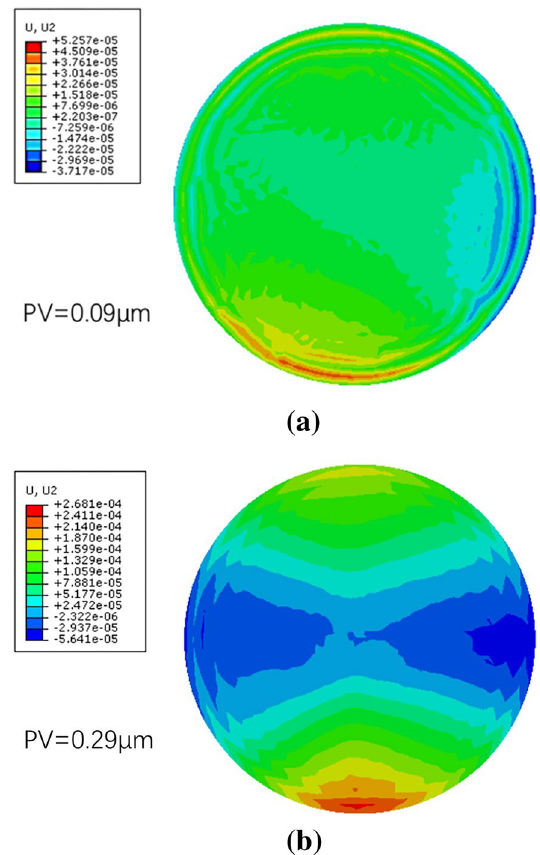
Figure 12 Simulation results of workpiece deformation caused by processing stress: ( a ) Strategy I; ( b ) Strategy